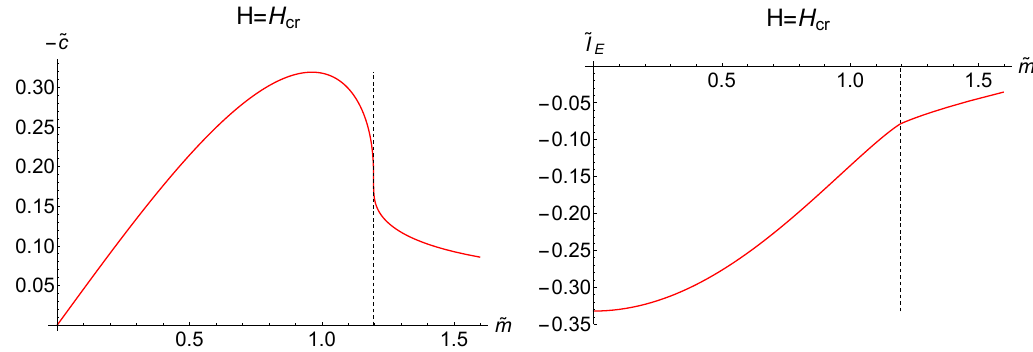
Figure 5. Plots of ~ c and ~ I E versus ~ m for H = H cr . The Dashed vertical line represents the (cid:0) critical parameter ~ m cr = 1 :